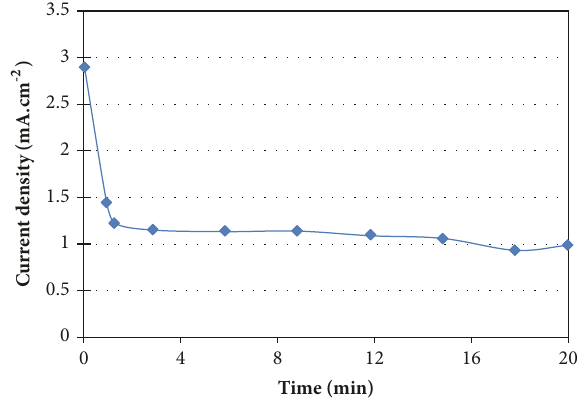
min, which obtained an average value of 1.125 ± 0.12 mA.cm −2 and indicated the self-pumping EBS stability.